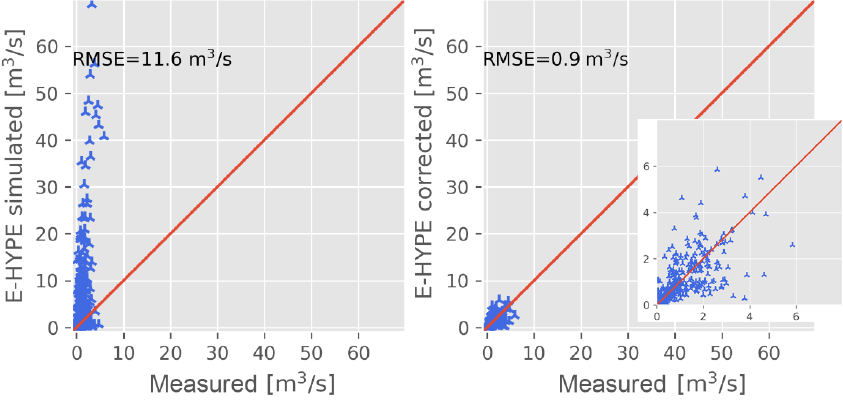
Figure 5. Comparison between monthly average river flow of the reference simulation of European Hydrological Predictions for the Environment (E-HYPE) (perfect run PR) and the measured data for the overlapping period of 1981–2010, before and after the application of downscaling and correction methodology to seasonal forecast data. In the lower plots, the details for a series of dry years ( left ) and wet years ( right ).